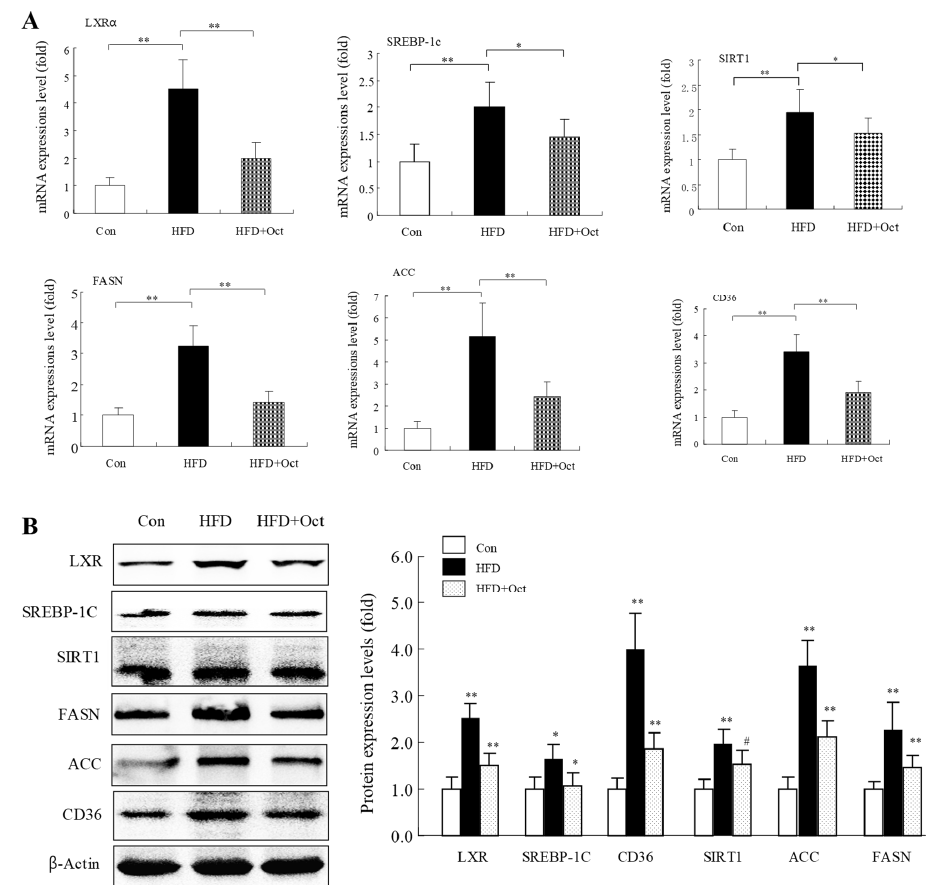
Figure 9. Octacosanol regulated expression levels of lipid metabolism-related genes in liver tissues. ( A ) mRNA expression levels analyzed by RT-PCR (three independent experiments); ( B ) protein expression levels analyzed by WB (three independent experiments). These genes included SREBP-1C, FASN, ACC, SIRT1, and CD36, which were differentially expressed caused by HFD in mouse liver tissue. Oct, octacosanol; HFD, high-fat diet; **: p < 0.01; *: p < 0.05; # : p > 0.05.